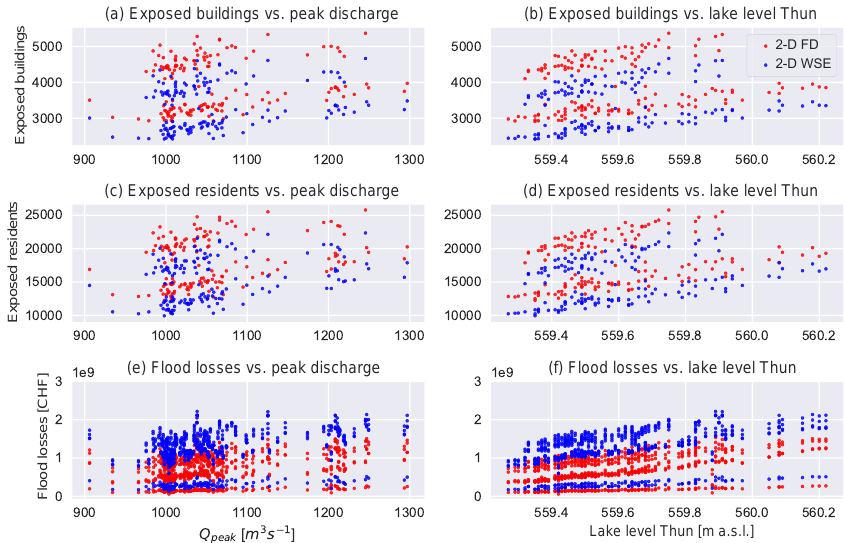
Figure 8. This figure shows the aggregated flood losses for the 150 PMP scenarios. The red dots show the exposed entities and losses that are computed based on the flow depths, the blue dots show the exposed entities and losses that are computed based on water surface elevation. The figures in the last row show the losses resulting from all vulnerability